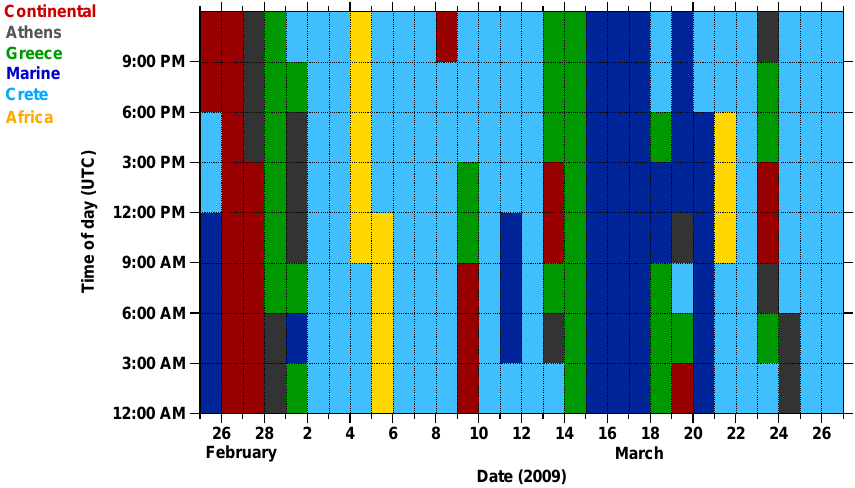
Fig. 1. Results of the source region analysis based on the FLEXPART footprint residence time plots (Stohl et al., 1998; Pikridas et al., 2010).